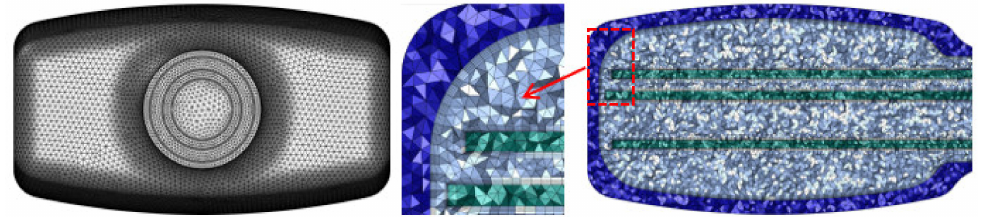
Figure 2. Generation mesh in the computational